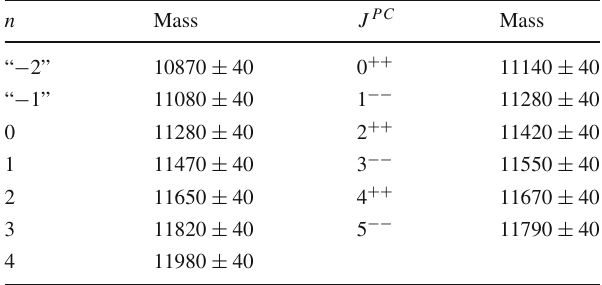
Table 12 Predictions for the states of the Y b , a tetraquark containing b ¯ b and decaying to (cid:9) b ¯ (cid:9) b . The mass of the first state is taken near threshold, masses of higher states are on the HMRTs that follow from the ground state